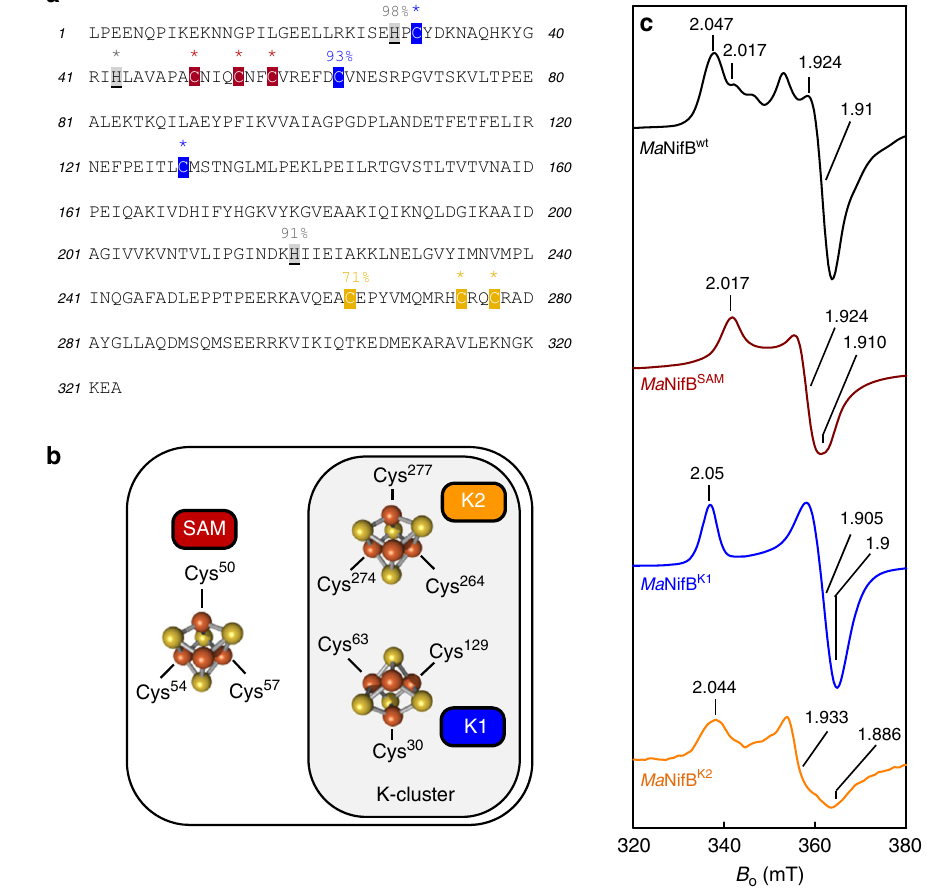
Fig. 1 Assignment of three [Fe 4 S 4 ] cluster modules in Ma NifB. a The primary sequence of Ma NifB. The Cys and His residues that are conserved among 45 NifB sequences from various organisms 14 are highlighted, with those 100% conserved indicated with a *, and others noted for the percentages of conservation among these organisms. b Schematic presentations of the SAM-, K1-, and K2-modules in Ma NifB. A 3-Cys ligation pattern is proposed for all three modules, with the proposed ligands indicated in each module. c EPR spectra of the synthetic [Fe 4 S 4 ] cluster-reconstituted wild-type Ma NifB ( Ma NifB wt , black) and Ma NifB variants carrying the SAM ( Ma NifB SAM , brown), K1 ( Ma NifB K1 , blue), and K2 ( Ma NifB K2 , orange) modules, respectively. The spectra were collected as described in Methods, and the g values of each spectrum are indicated. The CW EPR experiment was performed four times. Representative results are shown in c . See Supplementary Table 1 for Fe contents, spin concentrations and protein concentrations of EPR